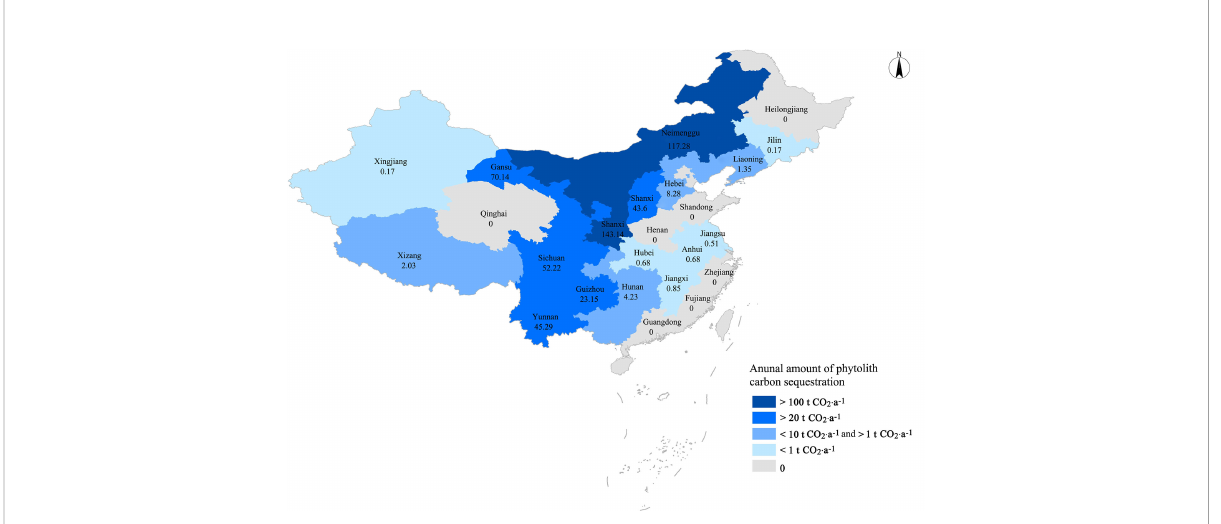
FIGURE 4 Annual amount and distribution of phytolith carbon sequestration of Chinese buckwheat planting in